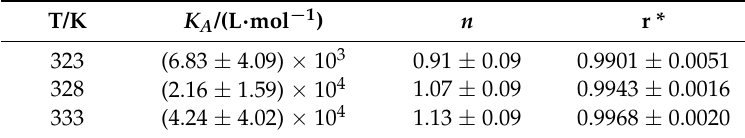
Table 2. Binding parameters of a lysozyme–tannic acid system at 323, 328, and 333 K.